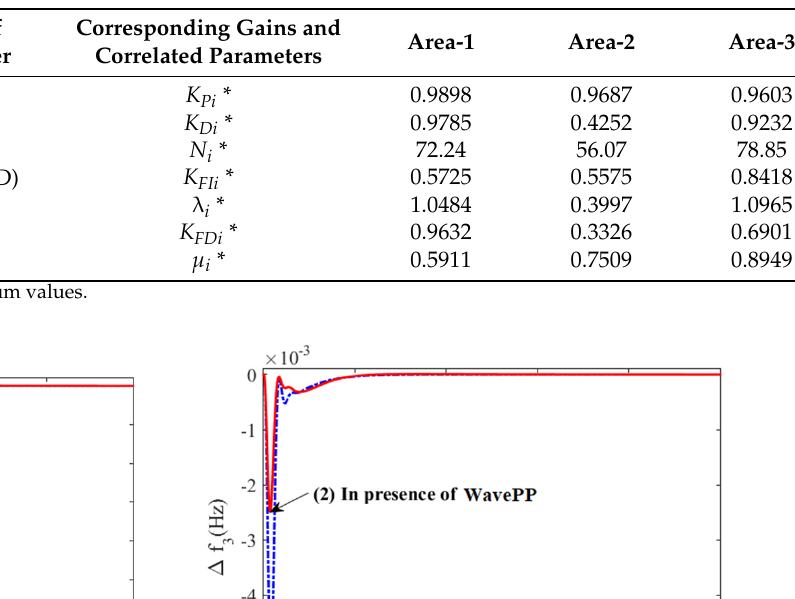
Table 5. Finest values of gains and related parameters of PDN(FOID) controllers for scheme-2.